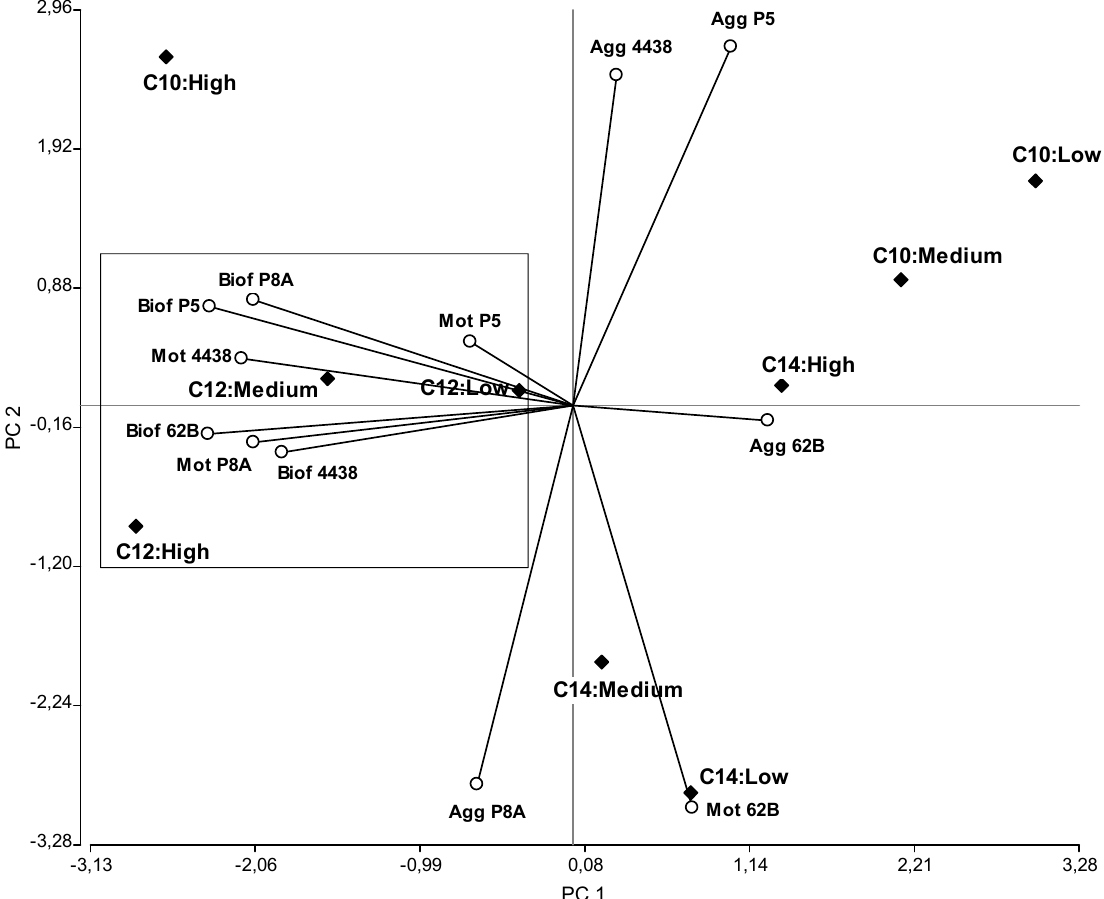
Graphic obtained from PCA using the software InfoStat version 2.0. Solid diamonds indicate various combinations of AHL type (C10: 3OC 5 μ M; medium: 10 μ M; high: 20 μ M). Open circles indicate the biological variables measured for each strain: motility (Mot), biofilm formation ability (Biof), and cell aggregation (Agg). The angles formed between the straight lines indicate the degree of correlation between variables. PC1: Principal Component 1; PC2: Principal Component